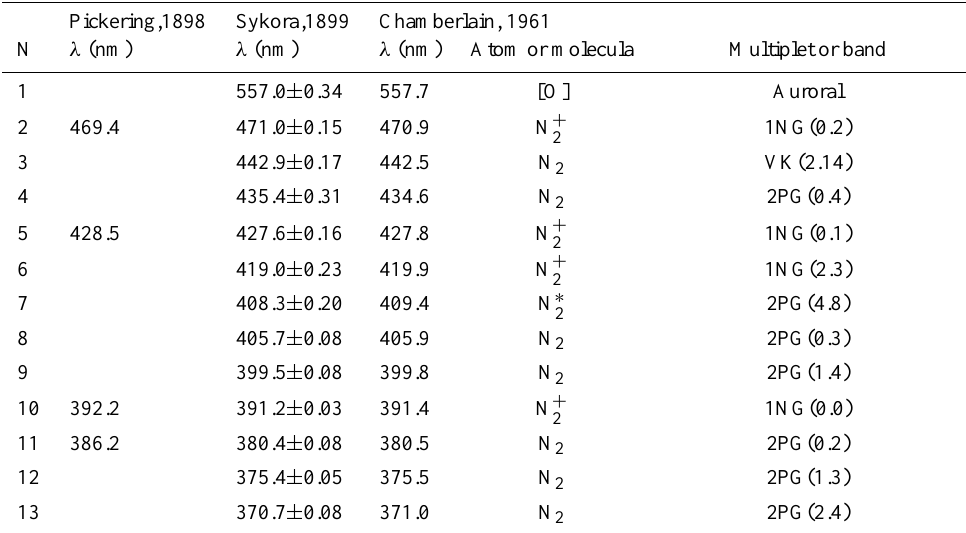
Table 1. Comparison of auroral emissions spectral positions on the basis of spectrographic data.